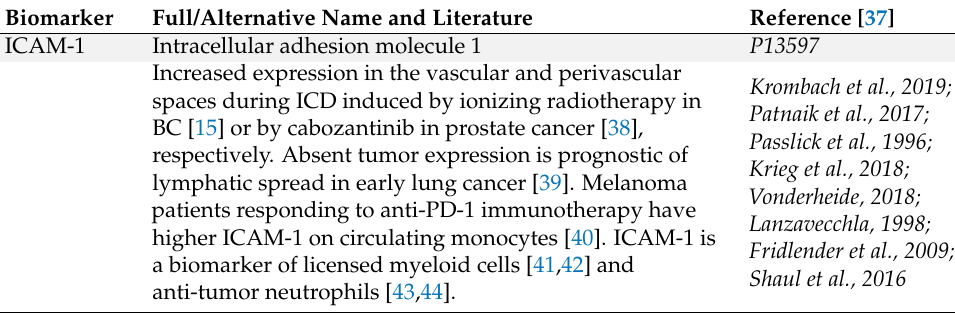
Table 1. IHC-based markers previously linked to ICD and/or